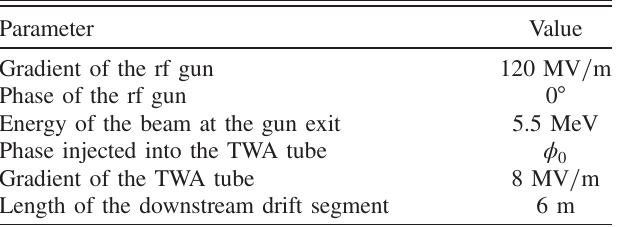
TABLE I. Parameters of the TTX beam line setup.